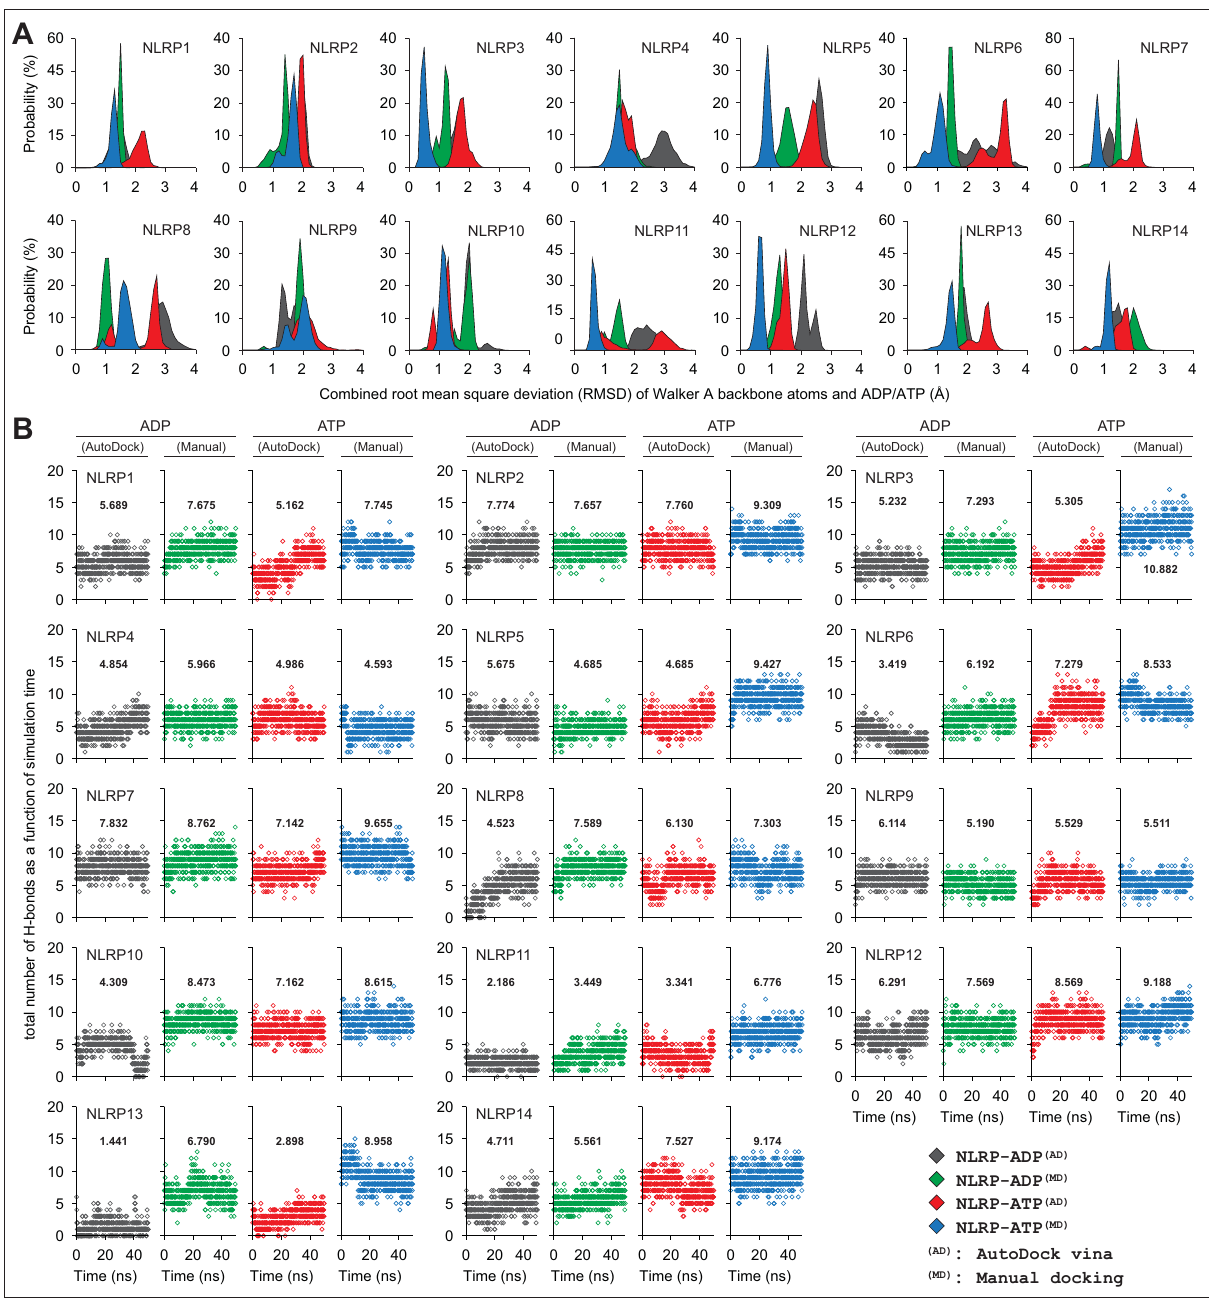
Fig 2. Analysis of NLRP NACHT -ATP/Mg 2+ complex stability and intermolecular H-bonds formed. (A) Distribution of ADP/ATP-Walker A combined RMSD calculated from 50 ns trajectories (X-axis represents the RMSD values and Y-axis denotes the distribution probability). (B) Intermolecular H-bonds between ADP/ATP and NLRP NACHT models of individual complexes, calculated from respective trajectories as a function of simulation time. The total numbers of H-bonds are depicted within the graphs. https://doi.org/10.1371/journal.pone.0209420.g002 with distance calculation results (S3 Fig) revealed that the first acidic residue ‘Asp’ (‘Glu’ in NLRP11) of the Walker B motif was found within 5 Å of ATP-Mg 2+ ; however, the interaction (within 6 Å of ATP) of second and third (‘Q’ in NLRP9 and ‘N’ in NLRP11) acidic residues (of